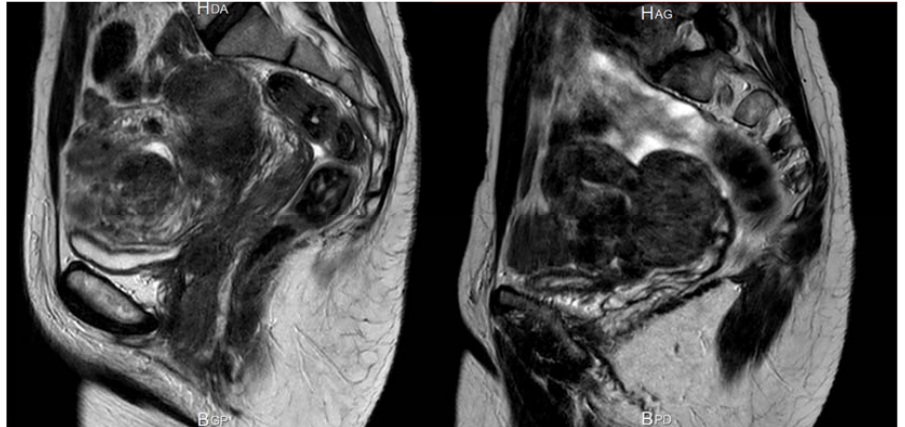
Figure 7. Significant reduction in myoma and uterine volume after 12 weeks of 200 mg/day linzagolix. At baseline, volume was estimated to be 396 cm 3 . After 12 weeks of treatment, it dropped to 169 cm 3 .